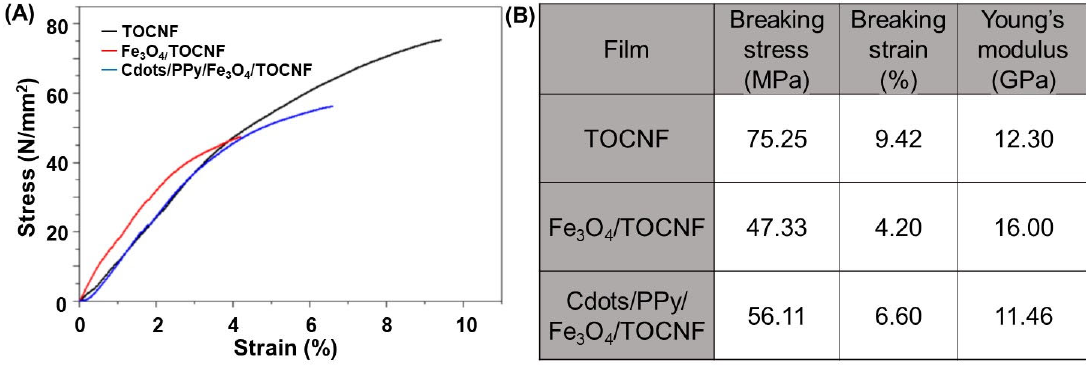
Figure 3. ( A ) Stress–strain curves and ( B ) a list of mechanical properties of TOCNF, Fe 3 O 4 /TOCNF and Cdots/PPy/Fe 3 O 4 /TOCNF films.